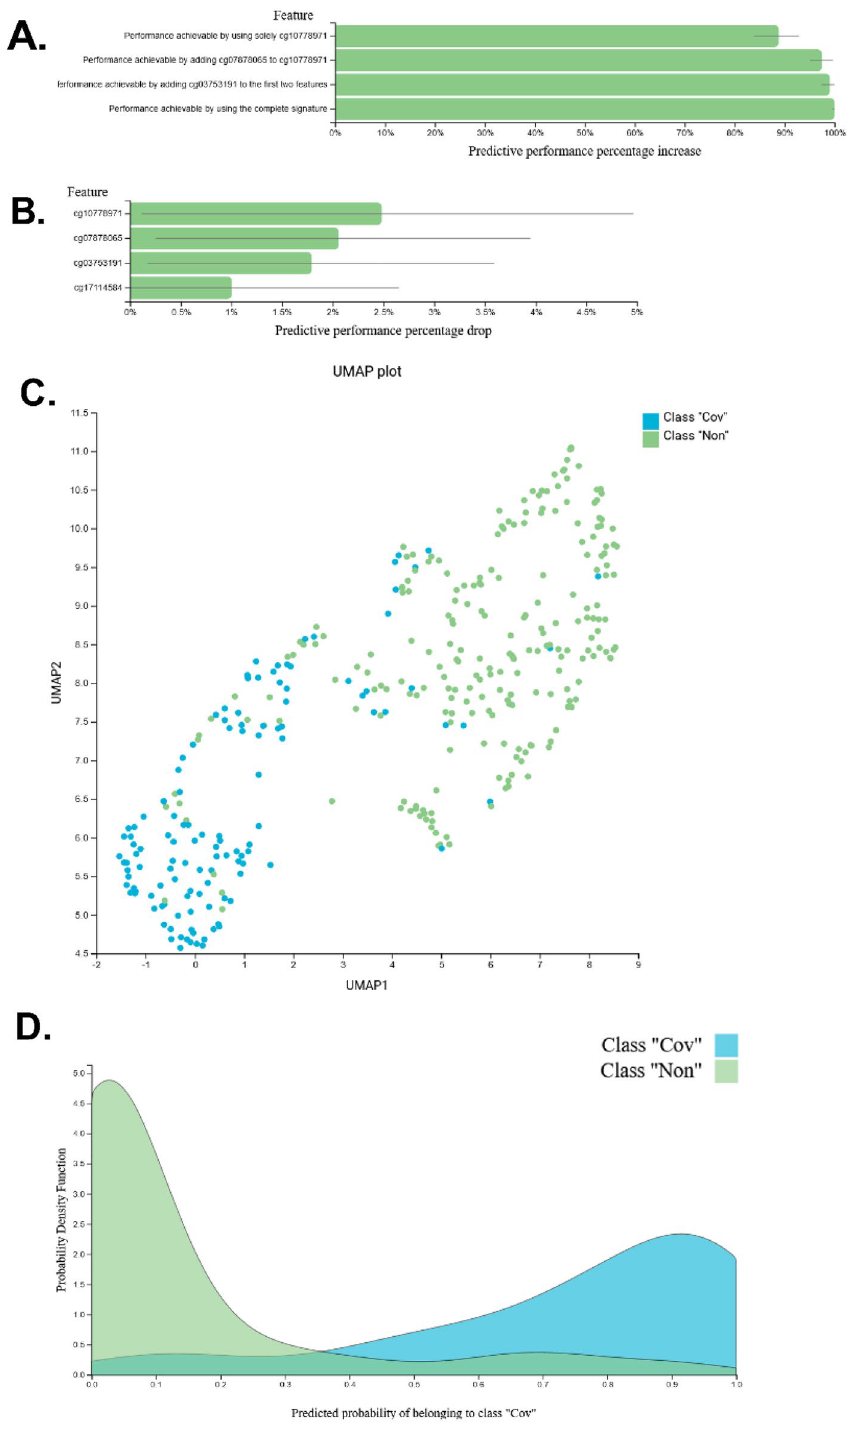
Figure 1. Feature selection and training performance. The selected features and performance characteristics of the training model are summarized. COVID-19 disease = “Cov”; Healthy individuals = “Non”. ( A ) The selected features consist of a single subset signature comprising 4 CpG sites shown by predictive performance increase when included in the model. ( B ) The predictive power losses by the model are reported for each CpG site removed. For some features, there may not be a noticeable loss in predictive power, however these features are included as an effort to make the final model more robust to noise. ( C ) Uniform manifold approximation and projection (UMAP) two-dimensional space projection with LASSO feature-selected CpG methylation M-values. ( D ) Separation of the predictions of the classes achieved by the model is shown in the density plot. These are the out-of-sample predictions made by the model produced by the same configuration as the final model when used for testing (e.g., during cross-validation) and not used to train the model. Well-performing models will display peaks at or close to 1 for COVID-19-infected individuals and 0 for uninfected